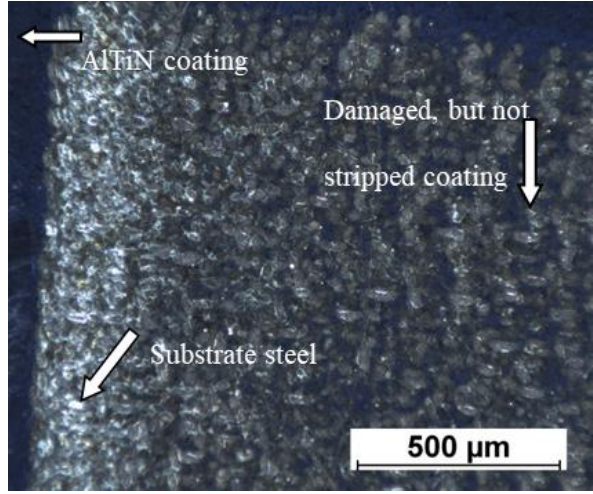
Figure 2. An example of an optical image of a laser-stripped sample.